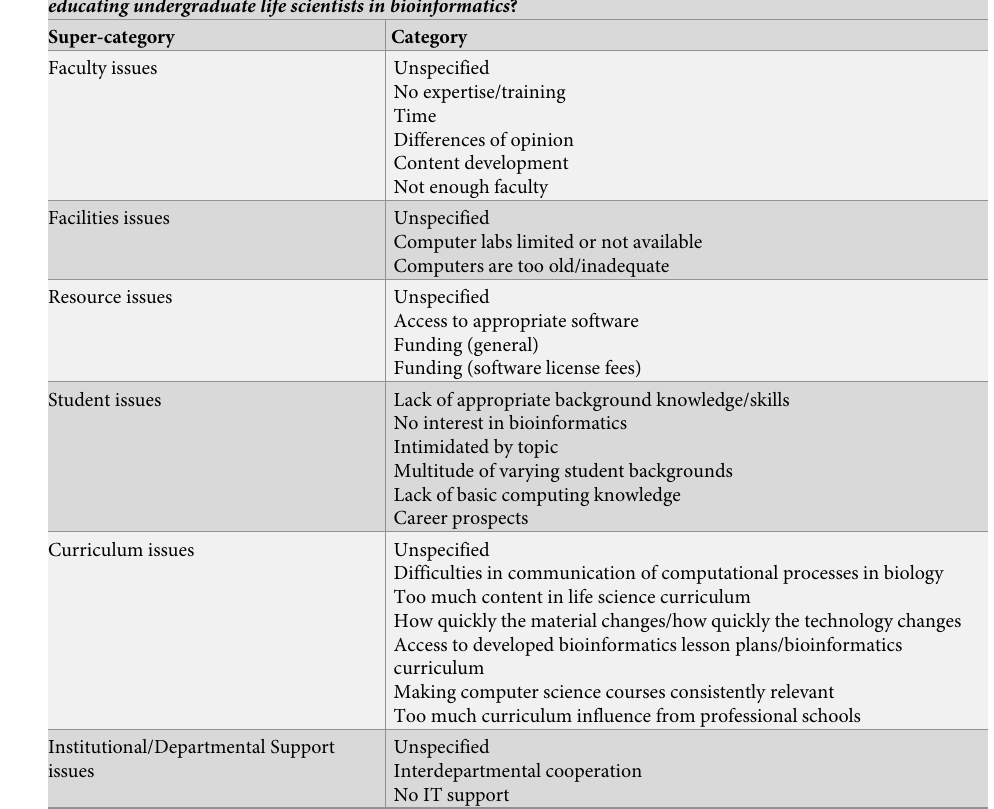
Table 2. Super-categories and categories of barriers in responses to Question